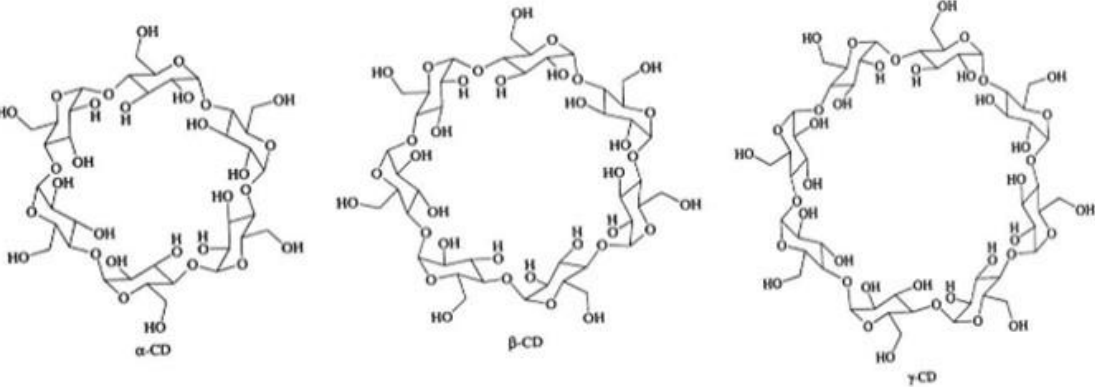
Figure 1. The structure of the cyclodextrin molecule resembles a torus, the inner part of which is hydrophobic, while the outer part is hydrophilic [5,6].